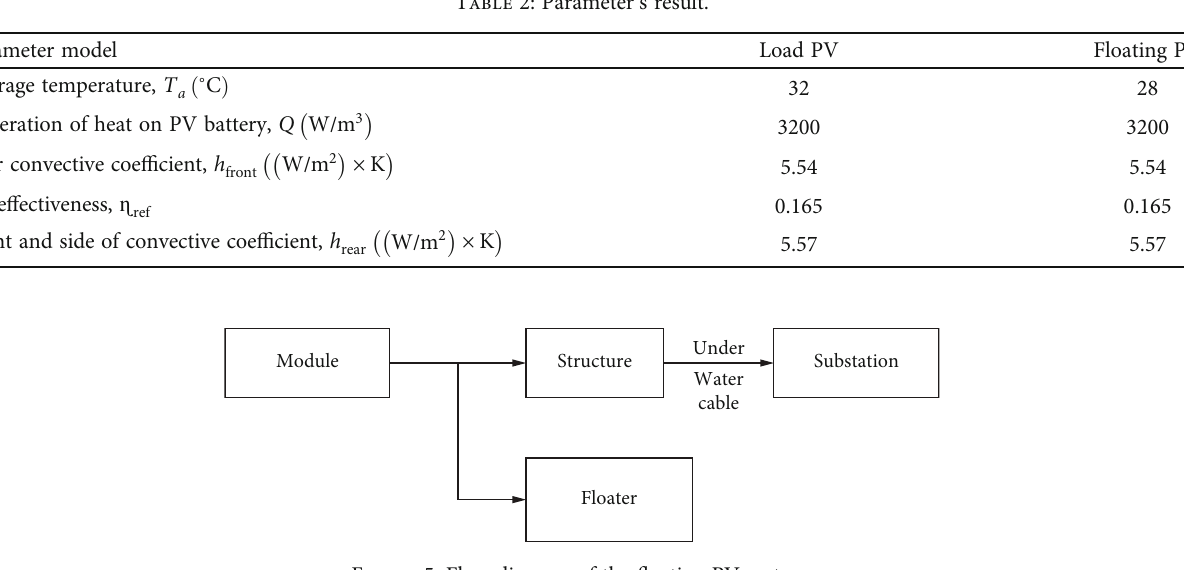
Table 2: Parameter ’ s result.